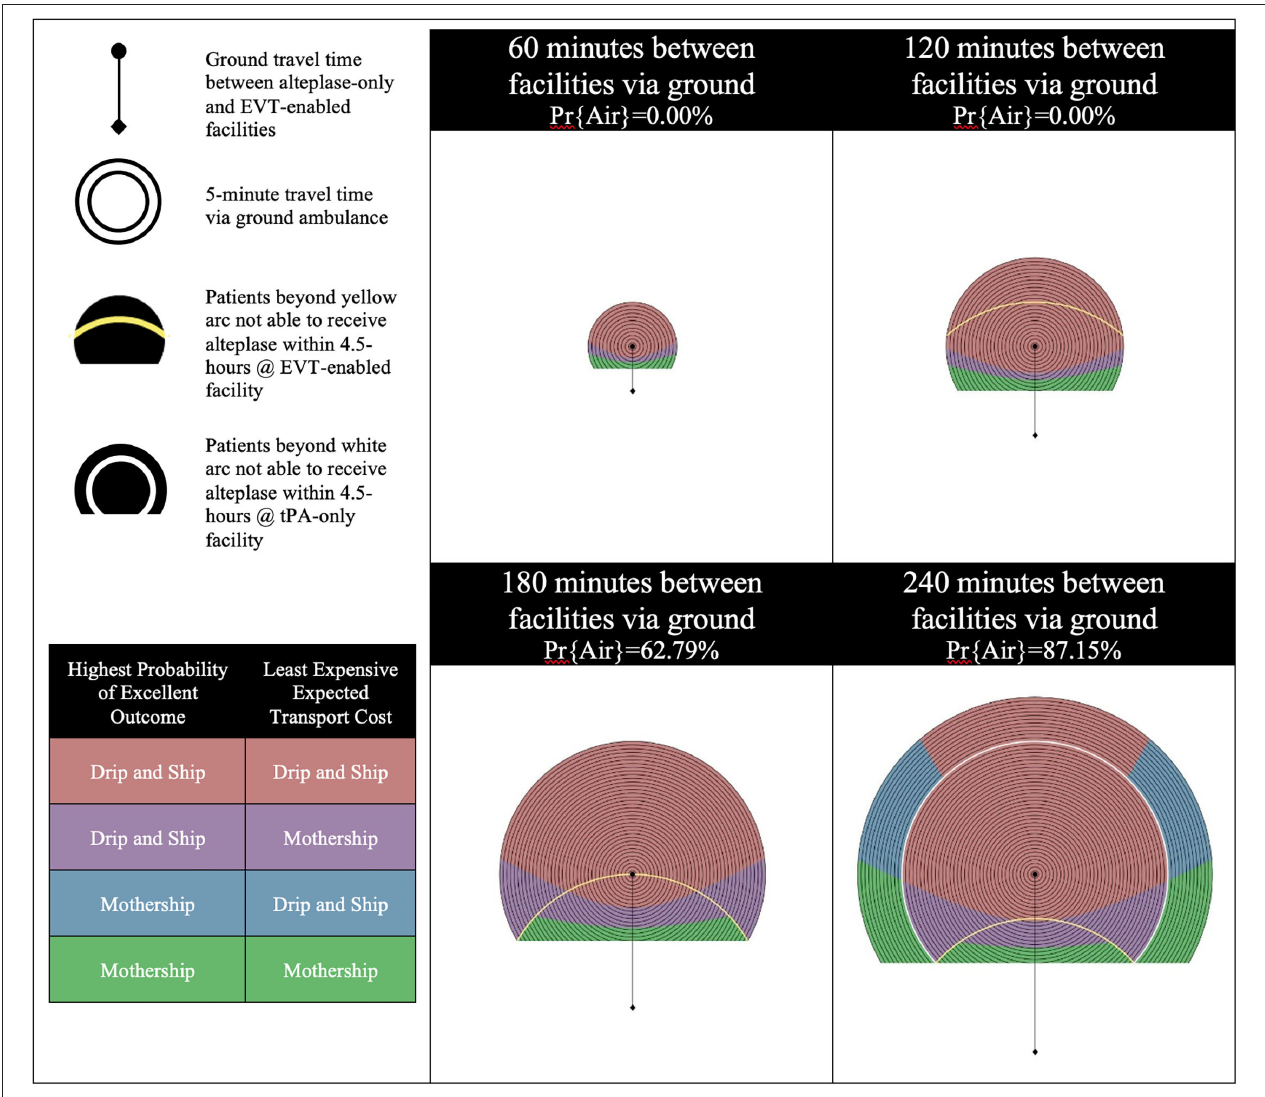
FIGURE 4 | Scenario D—Efficient alteplase-only facility and 70% EVT eligibility for LVO patients. LVO, Large Vessel Occlusion; Pr{Air}, Probability of air transport.